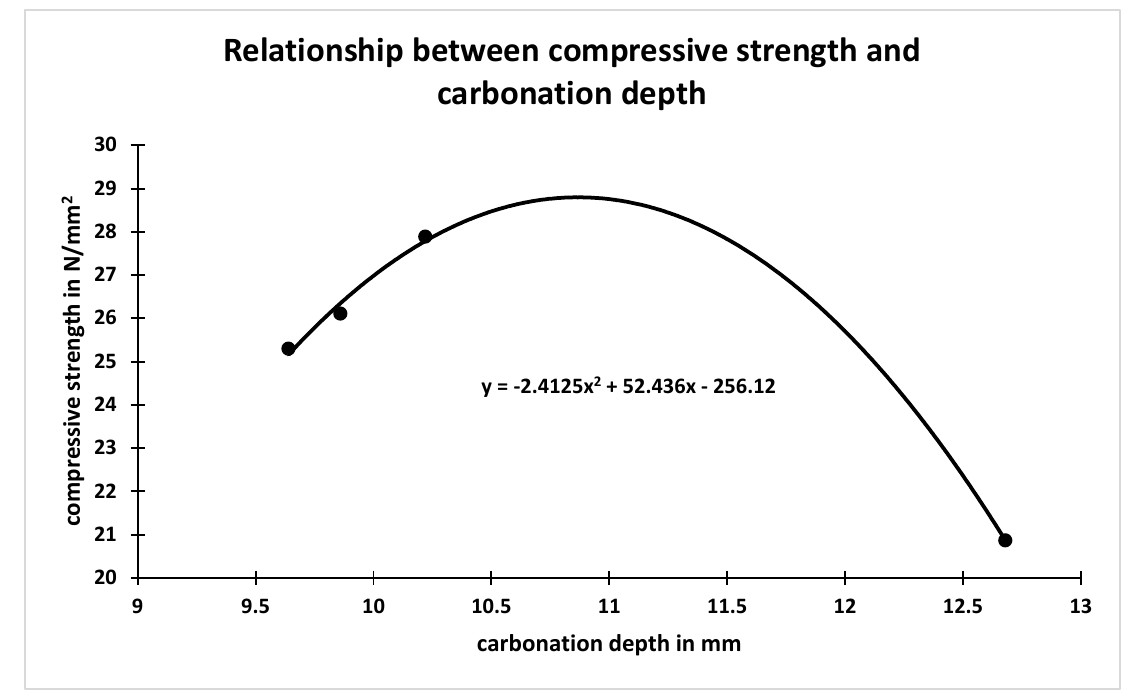
2021222324252627282930 y = -2.4125x 2 + 52.436x - 256.12 Figure 5. Relationship between compressive strength and carbonation depth. Figure 5. Relationship between compressive strength and carbonation depth. The coefficients of permeability of concrete mixes M2 and M6 are 3.44% and 85.86% compared to that of concrete M1, respectively. From Table 4, it is also observed that the coefficient of permeability of concrete for 1% soap solution increases with increasing percentage of rice hush ash content. It is also observed from Table 4 that the coefficient of permeability of concrete for 2% soap solution significantly decreases with increasing percentage of rice hush ash content. Further, from Table 4, it is also observed that the change in the coefficient of permeability of concrete made with partial replacement of cement by different percentages of RHA of 5%, 10% and 15%, compared to that concrete made with 1% and 2% soap solution concentration and without RHA, are − 34.48%, − 27.58% and − 31.03%, and 85.17%, 85.86% and 85.51%, respectively [50–54]. It is observed that the coefficient of permeability of concrete with 1% soap solution showed negligible change whereas the coefficient of permeability of concrete with 2% soap solution was reduced by 85.86% compared to mix M1. The coefficient of permeability of concrete made with 2% soap solution showed a significant reduction compared to mix M1 and this may be due to the hydrophobic action of soap solution in concrete which repels the water ingress. The coefficient of permeability of concrete made with different percentages of RHA (5%, 10% and 15%) compared to that of concrete made with 1% soap solution shows higher coefficient of permeability whereas when compared with 2 percent soap solution no significant change is observed [52–59]. A plot is made between coefficient of permeability of concrete and different percentage RHA for 1 and 2 percent of soap solution as shown in Figure 7. From Figure 7, it is observed that the coefficient of permeability of concrete for 2 percent of soap solution showed negligible change with increasing percentage of RHA content. Figure 6. Carbonation rate coefficient v / s RHA.